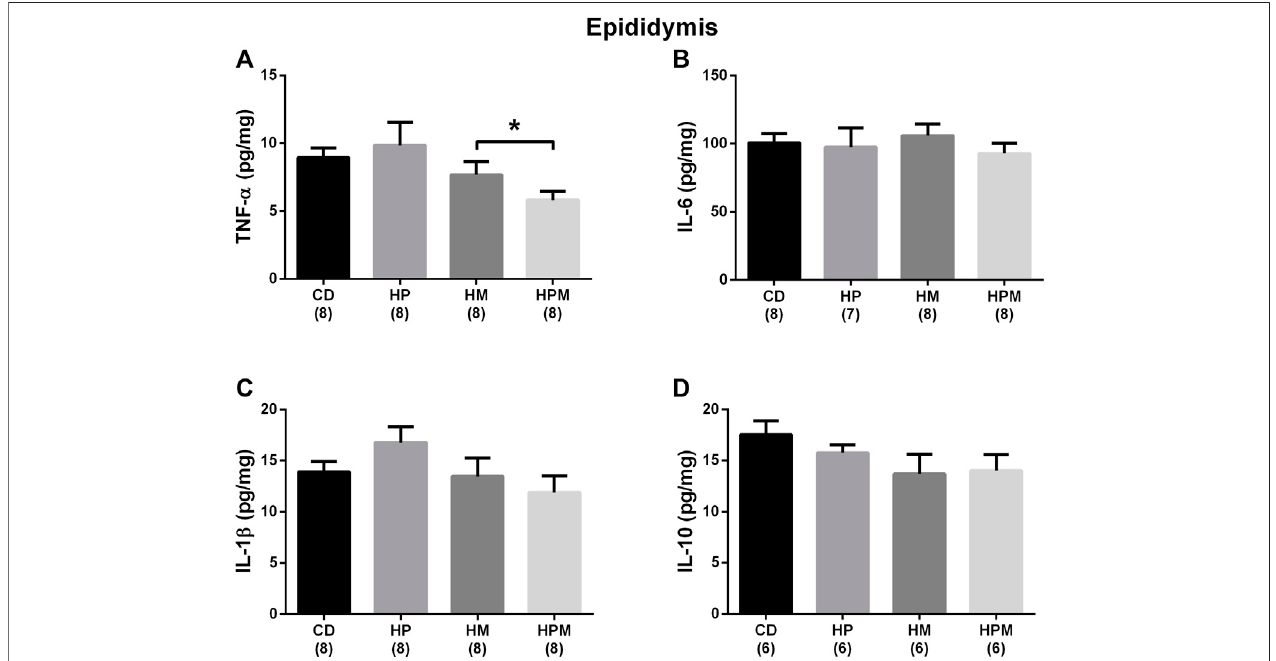
FIGURE 6 | Epididymal cytokine levels in male rat offspring from progenitors fed on high-fat high-sugar diet. Mean ± SEM; symbols indicate signi fi cant difference caused by parental diet ( p < 0.05): *statistically signi fi cant by the effect of maternal diet. H: high-fat and high-sugar diet; CD (control paternal and maternal diet), HP (H paternaldietandcontrolmaternaldiet),HM(Hmaternaldietandcontrolpaternaldiet)andHPM(Hpaternalandmaternaldiet).A:tumornecrosisfactor α (TNF- α )(pg/mg) ( n = 8); B: interleukin 6 (IL-6) (pg/mg) ( n = 7-8); C: interleukin 1 β (IL-1 β ) (pg/mg) ( n = 8); D: interleukin 10 (IL-10) (pg/mg) ( n = 6).